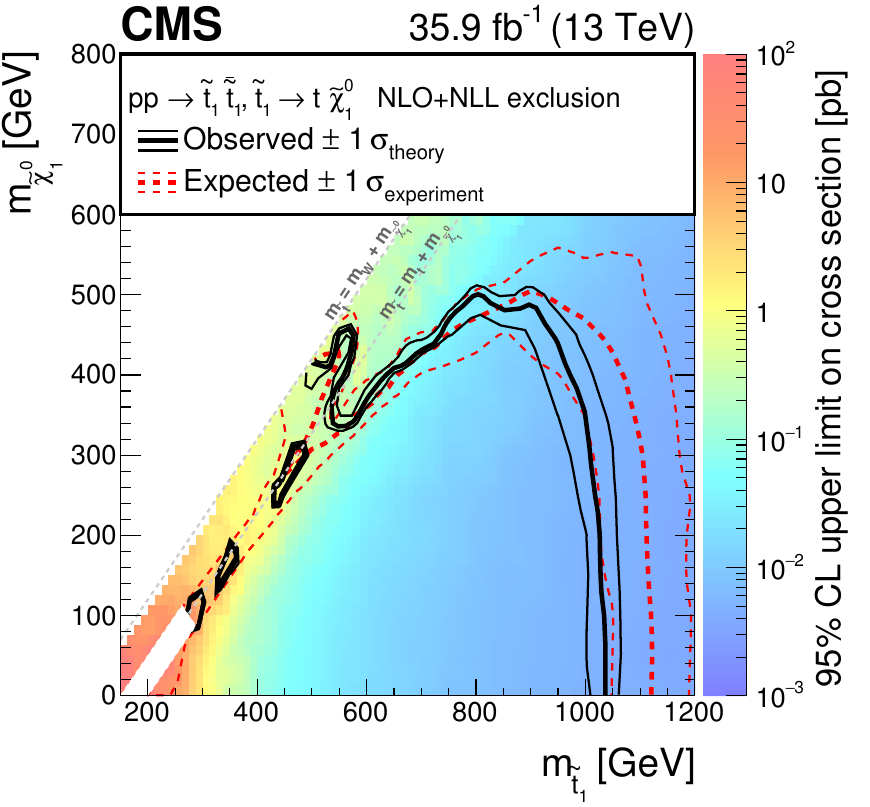
Figure 9 . Exclusion limits at 95% CL for top squark pair production followed by the decay t 1 ! t (cid:31) 0 (T2tt), in the mass plane m versus m . The areas to the left and below the solid 1 e t 1 e (cid:31) 0 1 black curves represent the observed exclusion and the (cid:6) 1 standard deviation contours for the e NLO+NLL cross section calculations and their uncertainties [65]. The dashed red curves represent e the corresponding expectation at 95% CL and (cid:6) 1 standard deviation contours for the associated experimental uncertainties. The \islands" represent regions that are not excluded by this